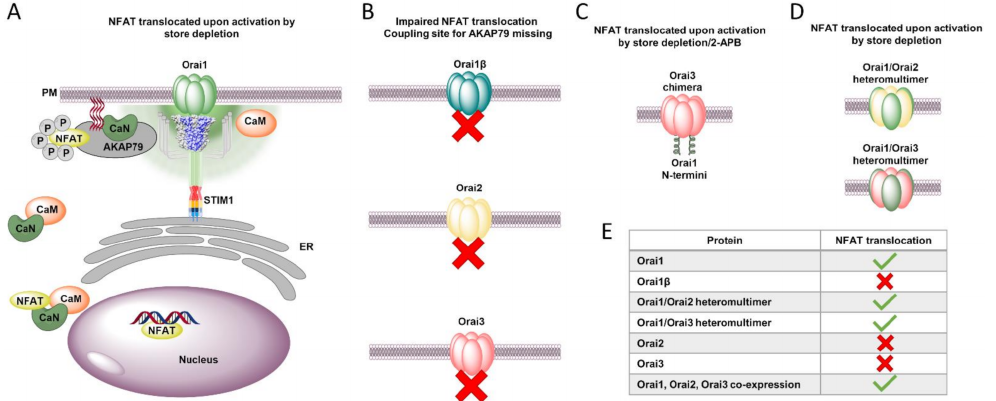
Figure 3. Nuclear factor of activated T-cells (NFAT) translocation pathway in dependence of Orai isoforms. ( A ) NFAT translocation is initiated by Orai1 Ca 2+ influx but not that of other Orai isoforms. The STIM1-activated Orai1 channel triggers a local Ca 2+ influx, which is sensed by the Ca 2+ sensor calmodulin (CaM, orange). Ca 2+ -bound calmodulin enables binding to the adjacent calcineurin (CaN) rapidly released by AKAP79. The cytosolic complex of Ca 2+ /calmodulin-calcineurin recognizes the phosphorylated NFAT and binds to its consensus sequence. In the following, NFAT is dephosphory- lated by CaN and subsequently translocated into the nucleus where it binds to its recognition site on the DNA. ( B ) The NFAT translocation is impaired (red cross) for Orai1 β , Orai2 and Orai3 due to the missing coupling site for AKAP79. ( C ) Chimeric mutant with Orai1 N-terminus recovers the impaired NFAT translocation of Orai3. ( D ) Orai1/Orai2 and Orai1/Orai3 allow NFAT translocation. ( E ) These requirements for NFAT translocation are summarized in the table (green check mark: NFAT translocation occurs; red cross: NFAT translocation does not